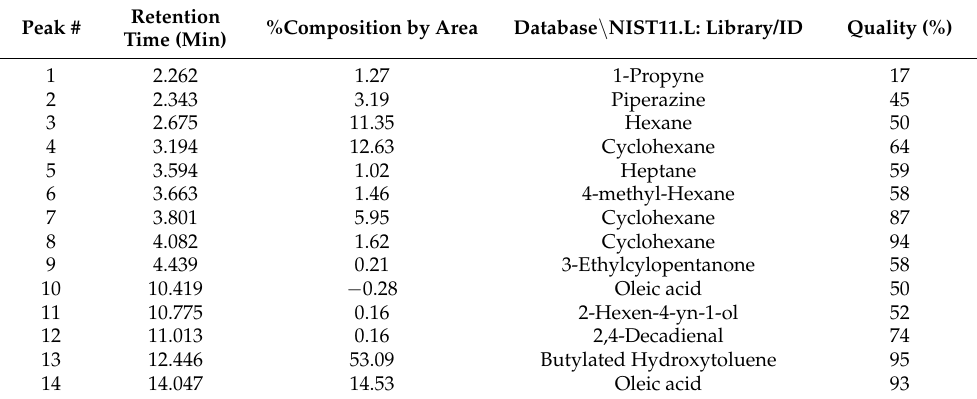
Table 5. GC-MS analysis of 2% BHT solution after thermal treatment for 15